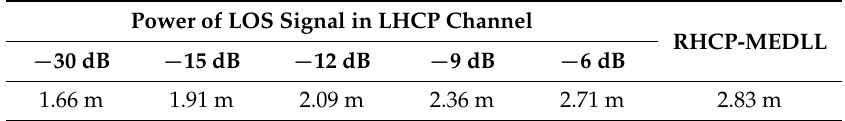
Table 5. The RMSE of the DP-SIMLE algorithm in the entire simulation as the power of the LOS signal in the LHCP channel